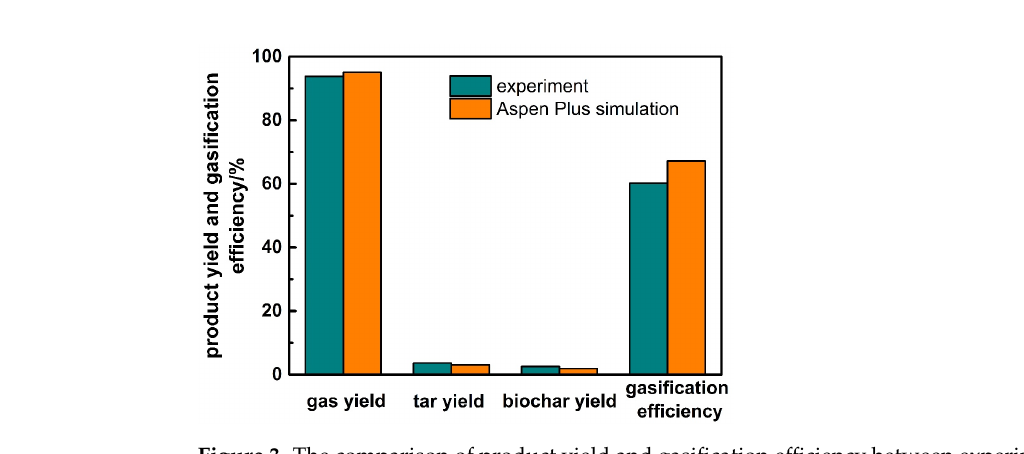
Figure 3. The comparison of product yield and gasification efficiency between experiment and Aspen Plus simulation results for the corn stalk.